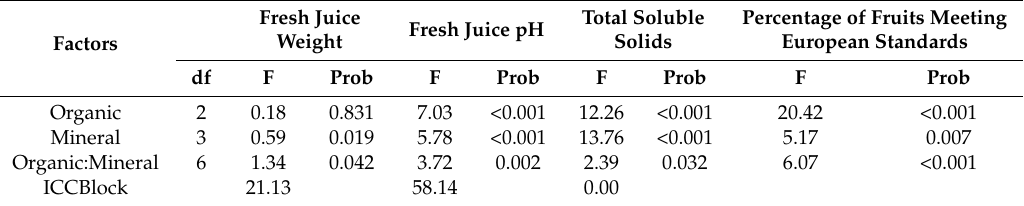
Table 2. Influence of organic and mineral fertilizer on fruit quality attributes. Fresh Juice Total Soluble Percentage of Fruits Meeting Fresh Juice pH Weight Solids European Standards Factors df F Prob F Prob F Prob F Prob Organic